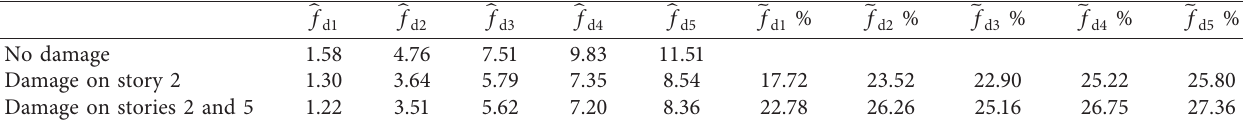
Table 5: Comparison of nominal and estimated frequencies after